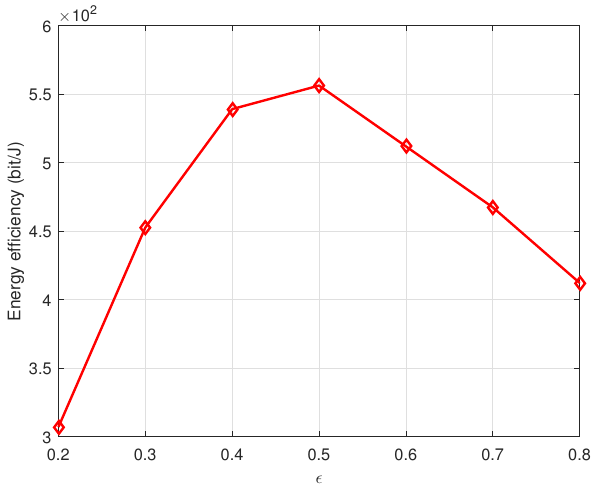
Figure 12. The performance of energy efficiency with different (cid:101) .